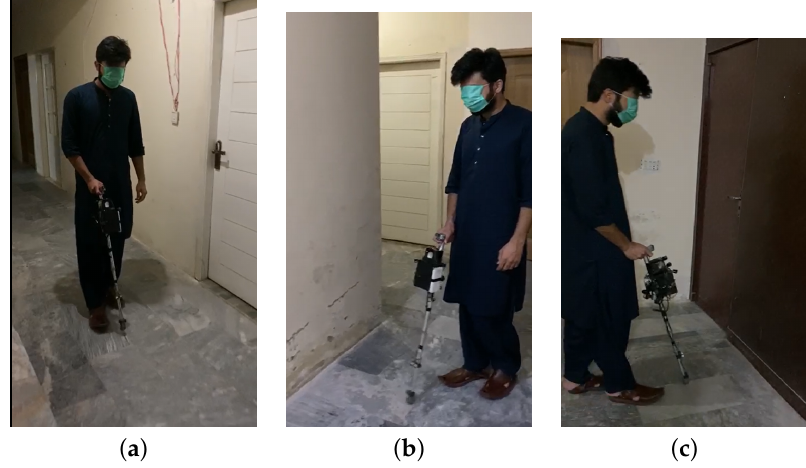
Figure 14. ( a ) Lab testing of the stick; ( b ) Side Obstacle Detected; ( c ) Front Obstacle Detected. Average Power Consumption